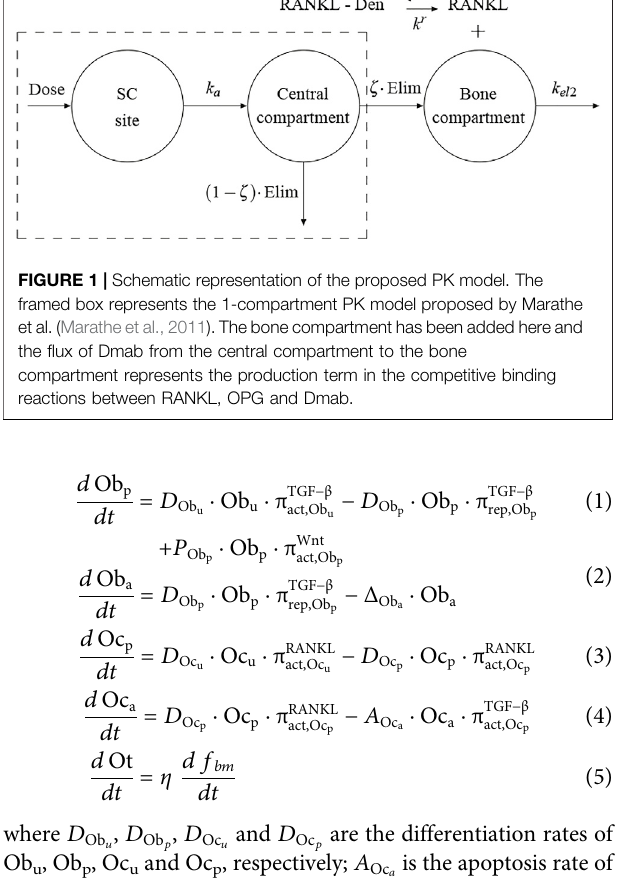
Figure 1 . Model parameters of the cell population model are given in the Supplementary Table S1 .